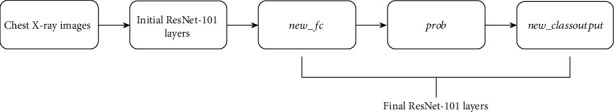
Initial and final layers of ResNet-101 deep learning network architecture employed in this study. All images need to be resampled to 224 px × 224 px × 3 channels to accommodate the network's input.